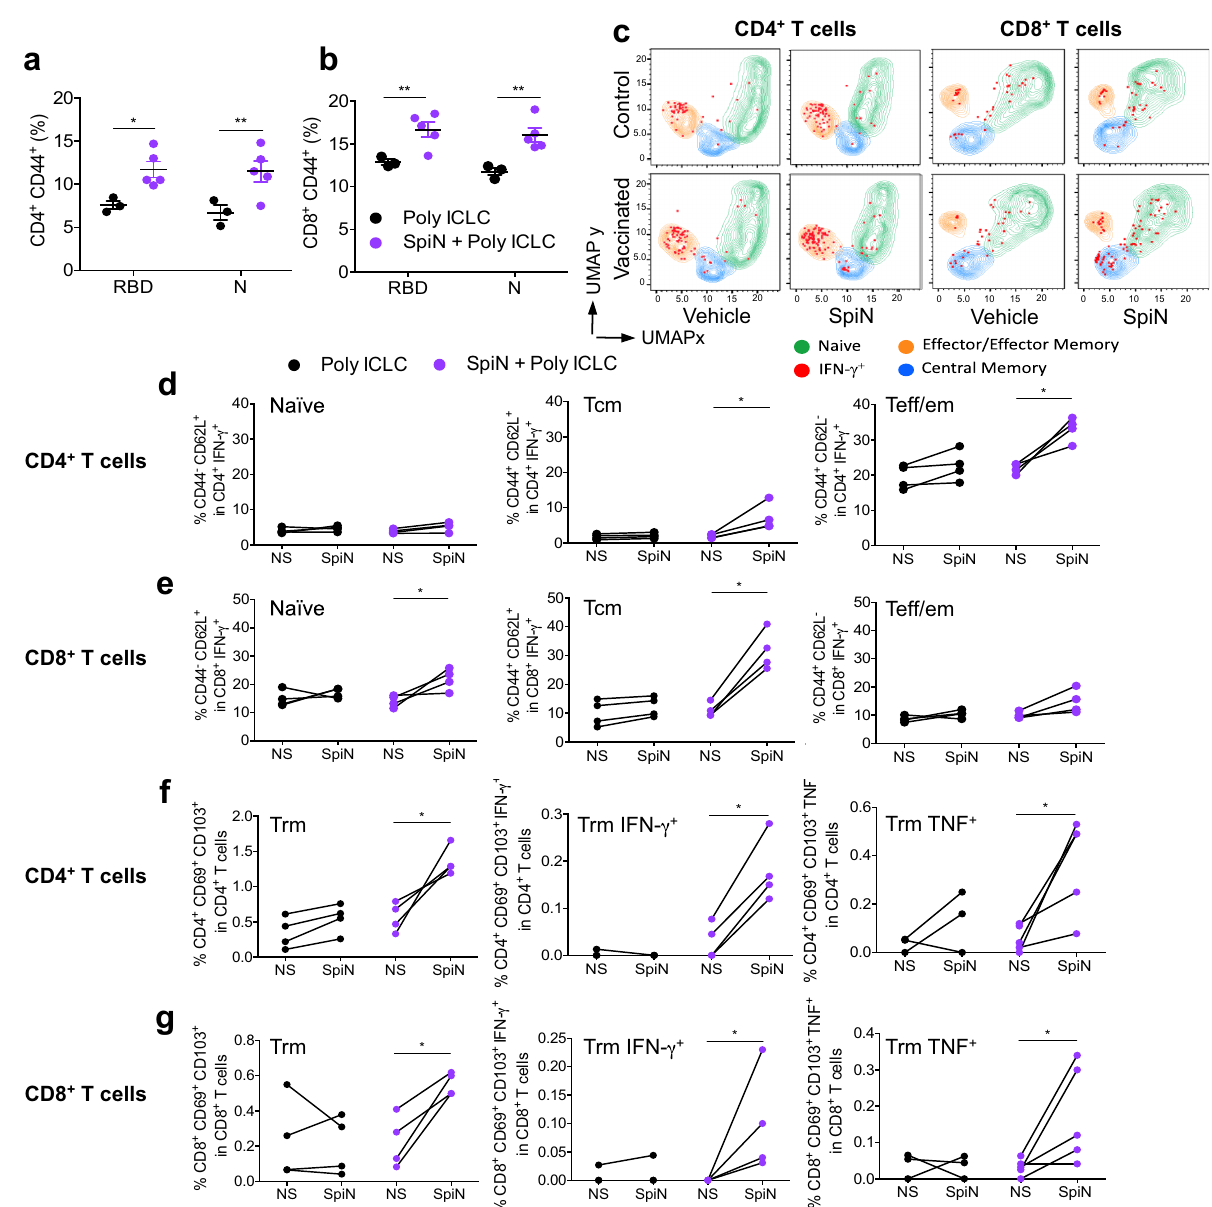
Fig. 4 | T lymphocytes response in the spleen and lungs of SpiN-immunized mice. The frequency of activated CD4 + T ( a ) and CD8 + T ( b ) lymphocytes was evaluated by measuring the expression of cell surface CD44, data are presented as mea±SEM. c UMAP projection of FACS data, in which splenocytes were gated on either CD4 + T or CD8 + T cell populations. Staining with anti-CD62L, anti-CD44 and anti-IFN- γ was used to de fi ne IFN γ -producing naïve, central memory (Tcm), and effector/effector memory (Teff/em) T cells. The frequency of naïve, memory and effectorCD4 + TandCD8 + TpopulationsproducingIFN- γ